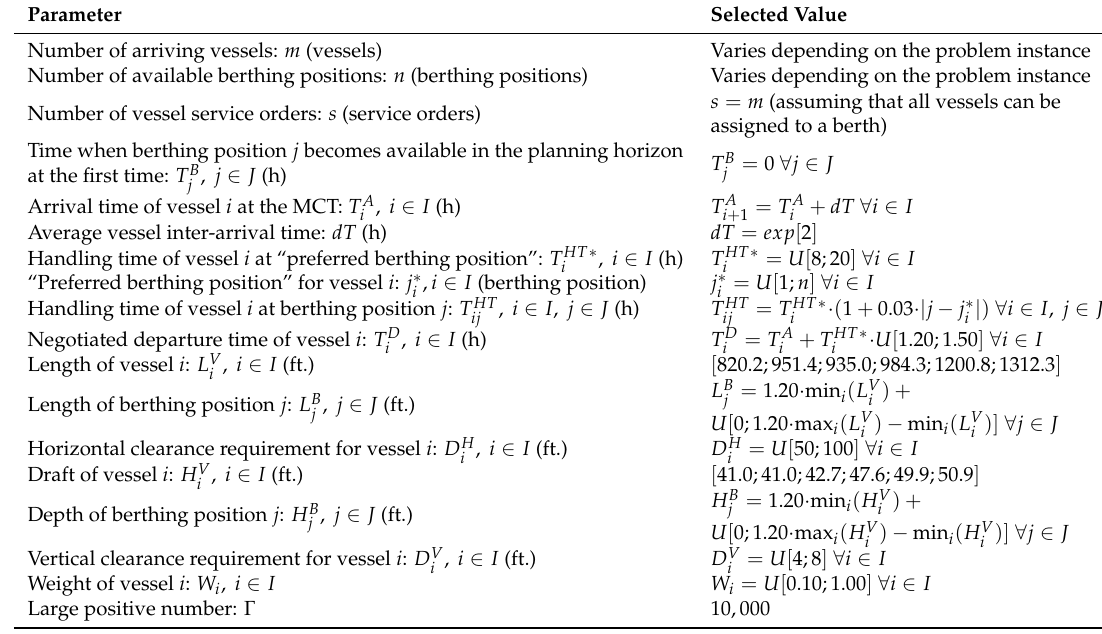
Table 2. Adopted parameter